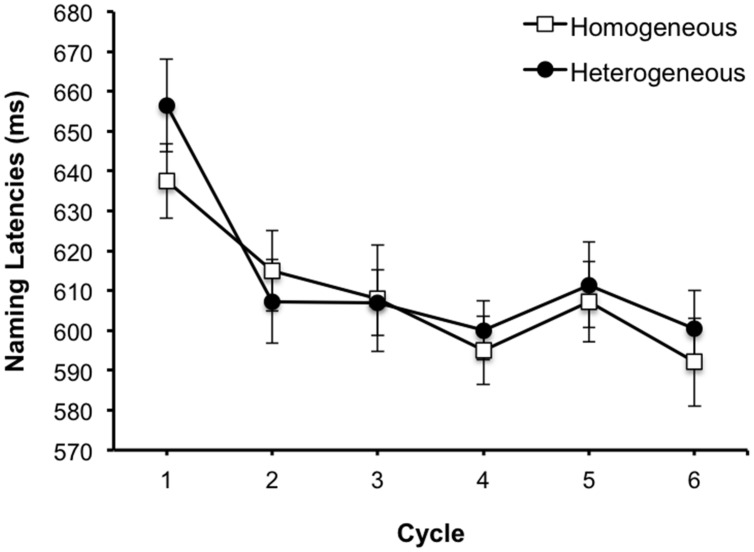
Mean correct superordinate categorization latencies as a function of context and cycle in the blocked cyclic paradigm in Experiment 3. Error bars represent 95% CIs calculated per Cousineau’s (2005) method.